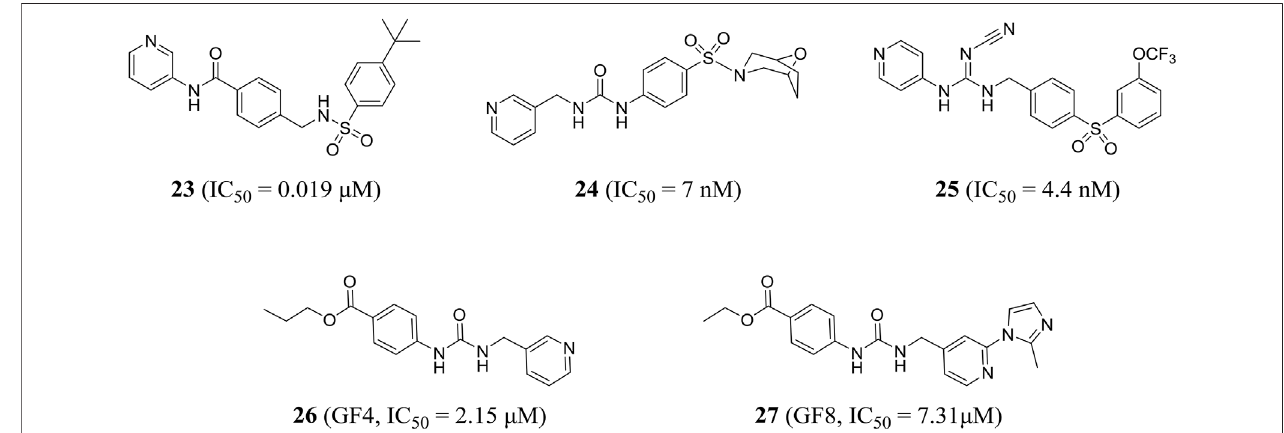
FIGURE 7 | Chemical structures and kinase activities of NAMPT inhibitors 23 – 27